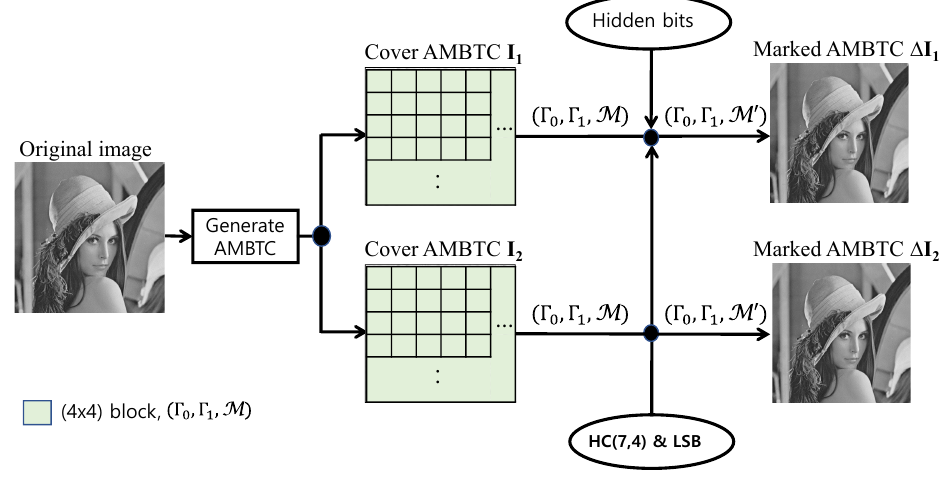
Figure 2. Schematic diagram for the proposed